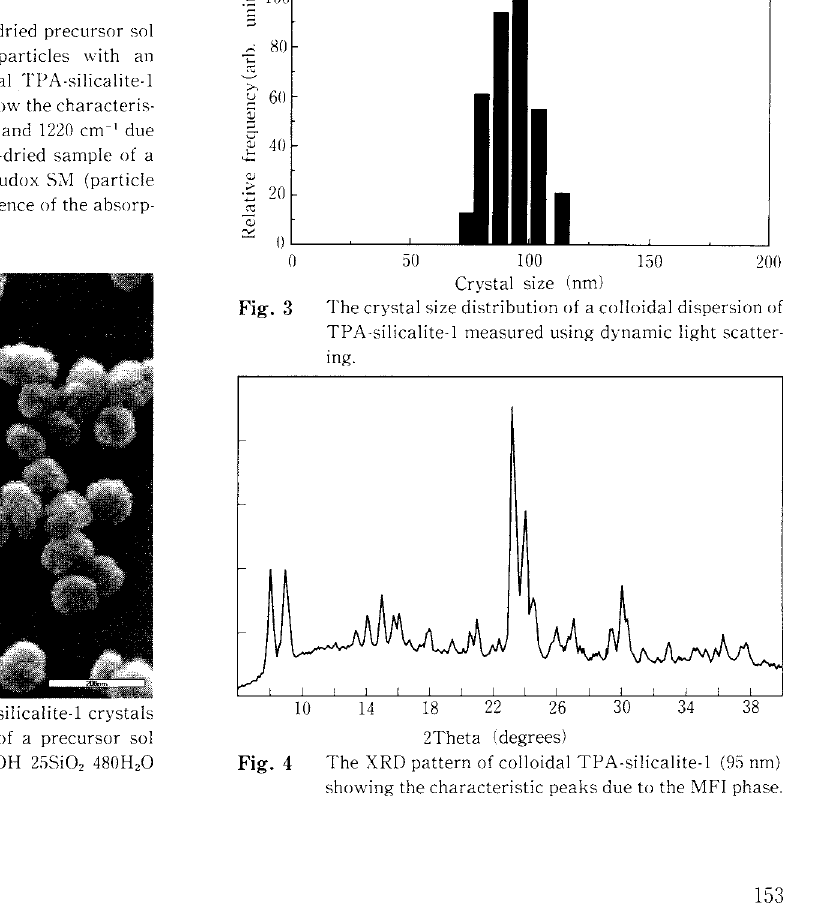
The FT-IR spectra of (a) a freeze-dried precursor sol containing subcolloidal siliceous particles with an average size of 2.6 nm, (b) colloidal TPA-silicalite-1 (90 nm) -both spectra (a) and (b) show the characteris tic absorption bands at approx. 550 and 1220 cm- 1 due to the :'v1FI phase. and (c) a freeze-dried sample of a commercial amorphous silica sol. Ludox S:'vl (particle size approx. 7 nm). showing the absence of the absorp tion band at approx. 550 em 1•